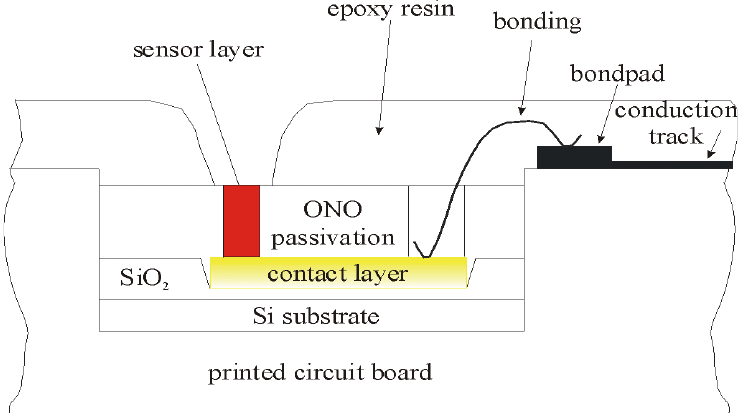
Figure 2. Schematic cross-section of the chalcogenide glass-based sensor chip after bonding and